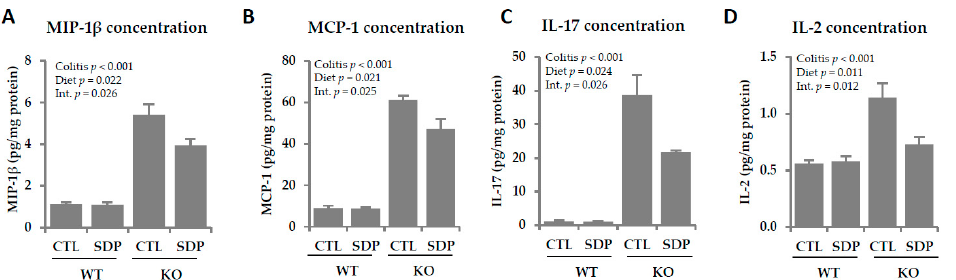
Figure 4. E ff ects of SDP supplementation on cytokine secretion in the colonic mucosa of Mdr1a KO mice. ( A ) MIP-1 β concentration; ( B ) MCP-1 concentration; ( C ) IL-17 concentration; ( D ) IL-2 concentration. Results are expressed as mean ± SEM ( n = 5–7 mice / group). CTL, control; IL-2, interleukin-2; IL-17, interleukin-17; Int., interaction between colitis and dietary factors; MCP-1, monocyte chemoattractant protein 1; MIP-1 β , macrophage inflammatory protein 1 beta; SDP, spray-dried porcine plasma.